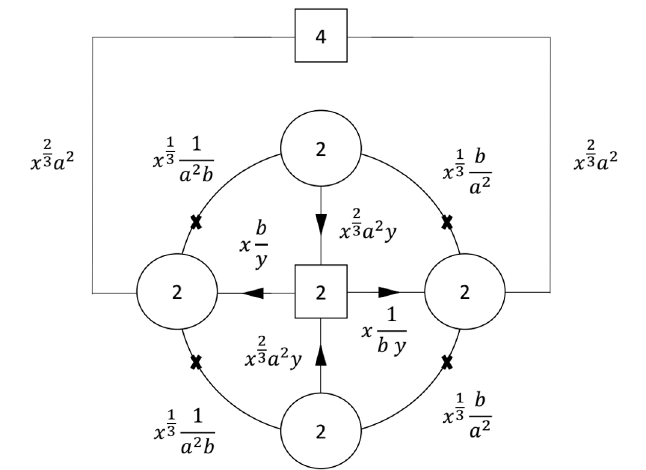
Figure 6 . The 3 d quiver theory associated with the compactification of the 5 d E 7 SCFT on a torus √ with flux ( 2; 1 , 1 , 0 , 0 , 0 , 0) . In the figure we have used fugacities to represent the charges of the fields under the global symmetries, specifically, the fugacities a , b and y for the three U(1) global symmetries and x for the R-symmetry. The theory also contains various superpotential interac- tions, which correspond to all operators build from the fields that carry R-charge 2 and are global symmetry singlets. For completeness, we note that these include the four cubic superpotentials running along the triangles, the flipping superpotentials and two quadratic superpotentials running along the two bifundamentals connected to the global SU(4) in the upper square and the upper and lower semi-circles. Finally, there are four monopole superpotential of the type (1 , 1) for all adjacent SU(2)